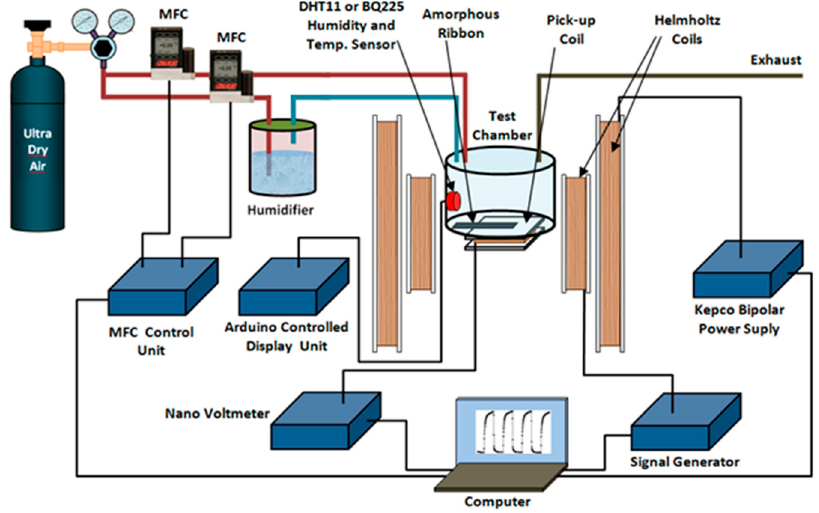
Figure 1. Schematic illustration of humidity measurement system.